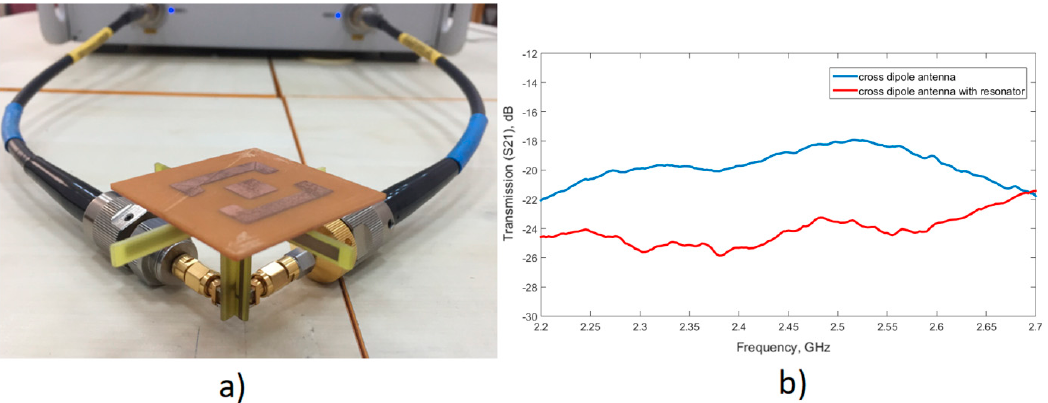
Figure 9. ( a ) Fabricated cross dipole antenna and ( b ) resonator layer integrated cross dipole antenna.